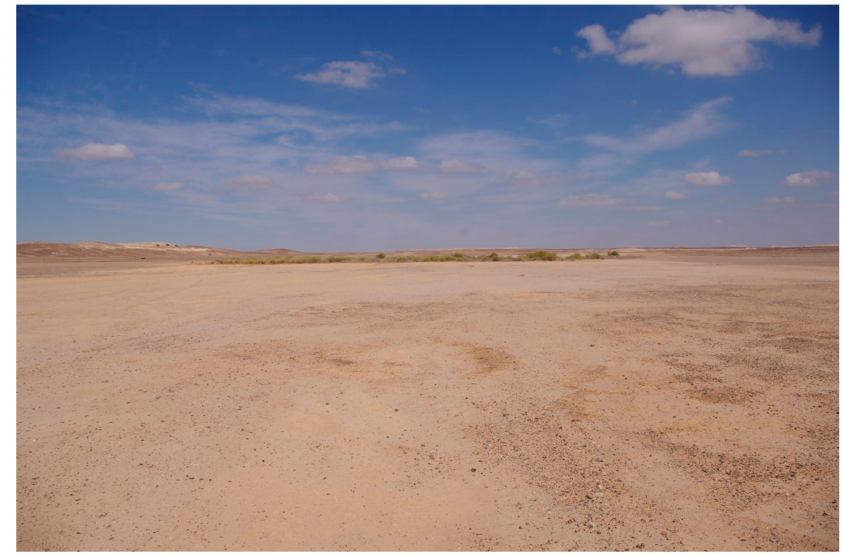
Figure 4. Girzi Playa (Qa Girzi), a northward sight. Notice the dense shrubby vegetation in the playa’s bottom. Picture taken by Ilan Stavi.